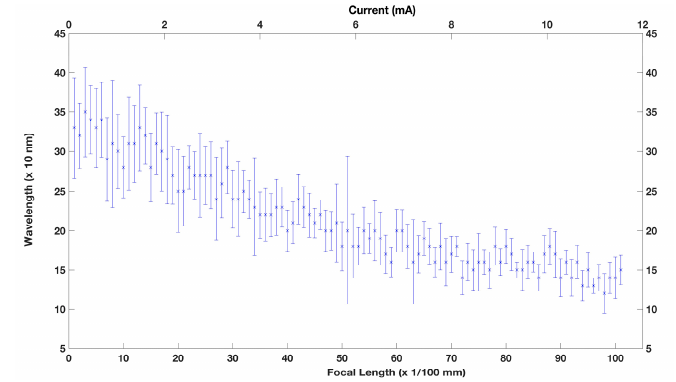
Figure 3. Focusing ability of the designed Fresnel zone plate. The horizontal axis shows the focal distance of the main harmonic of each wavelength. The MEMS actuator can move over a distance of 1 mm, which can selectively focus UV wavelengths from 150 nm to 410 nm onto the detector. The top x axis shows the amount of current that must be applied to the MEMS actuator of Figure 2, to displace the